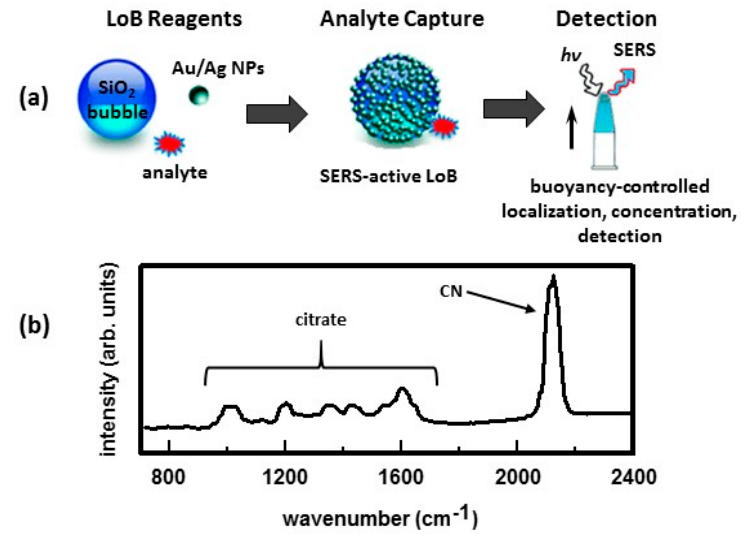
Figure 15. ( a ) The basic components of a lab-on-a-bubble (LoB) assay for SERS-based detection of an analyte; ( b ) SERS spectra of cyanide and citrate on LoB. Reproduced with permission from the American Chemical Society, 2012 [158].